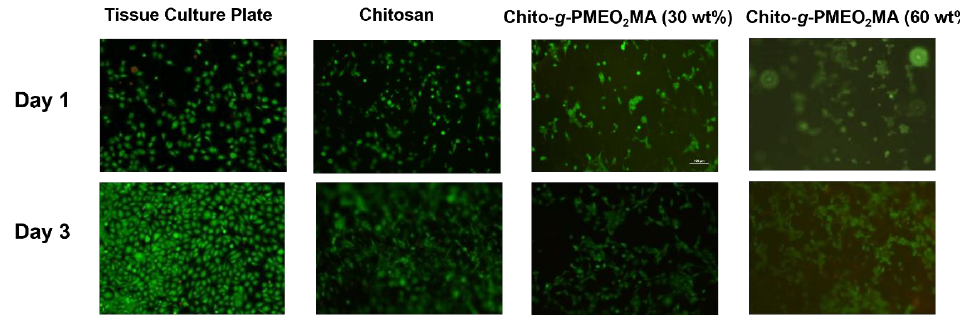
Figure 7. HCEC viability on chitosan, Chito- g -PMEO 2 MA (30 wt %), Chito- g -PMEO 2 MA (60 wt %), and TCPS (control). Representative live/dead staining of HCEC on chitosan films and TCPS 1 and 3 days after seeding. Calcein AM stains live cells green and EthD-1 stains dead cells red.